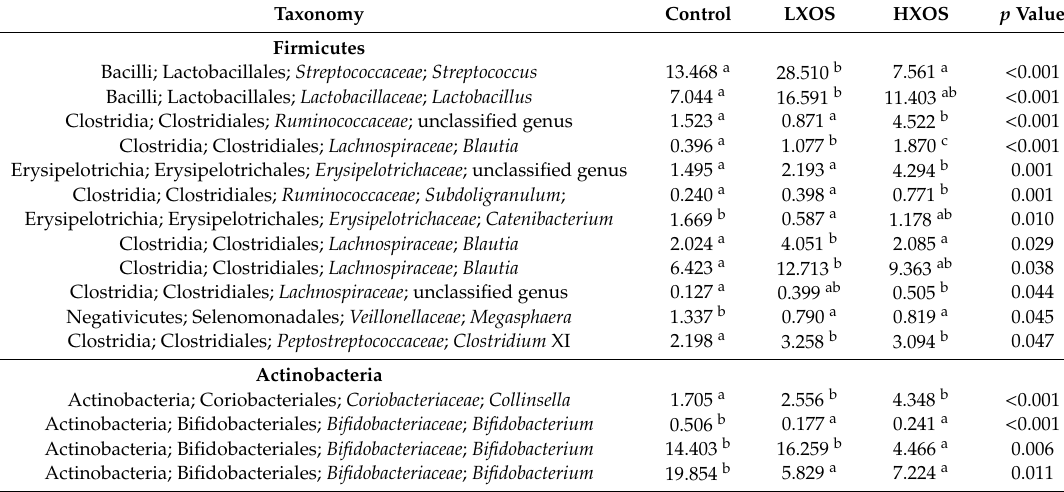
Table 2. Relative abundance of the operational taxonomic units